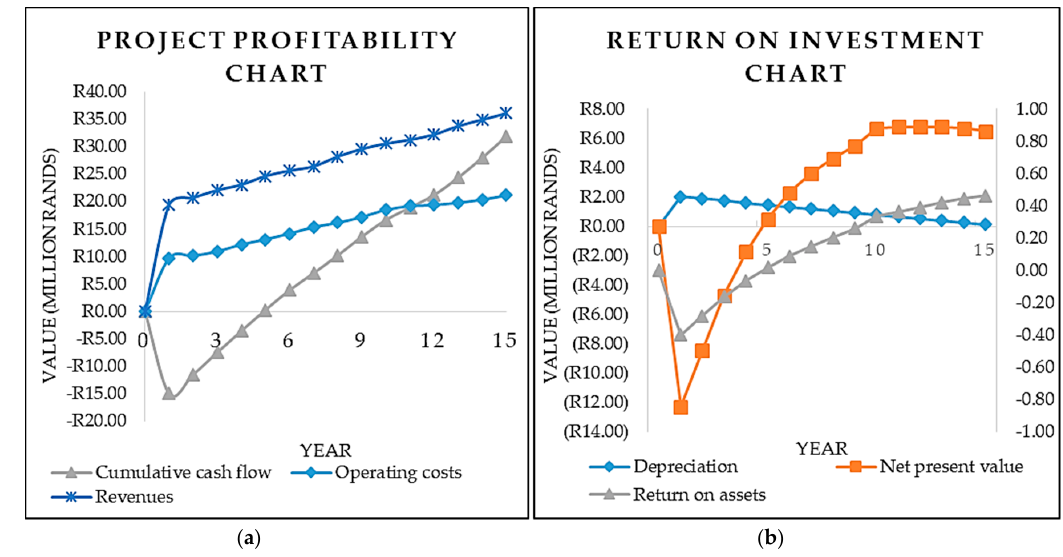
Figure 4. Project cost evaluation: ( a ) Cumulative cash flow, revenues and operating costs projections; ( b ) Net present value, return of assets, and depreciation rate